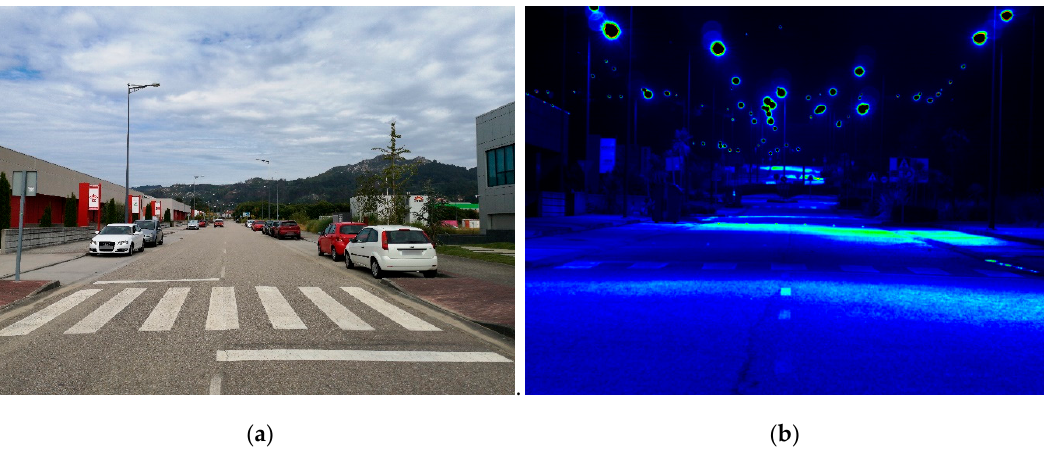
Figure 7. Road lighting installation considered to verify the methodology: ( a ) picture of the real scenario; and ( b ) luminance image photographed with the luminance meter.